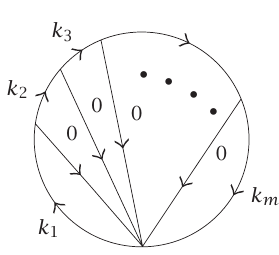
Figure 2.1 . Sea shell diagram representing the general Euler-Zagier